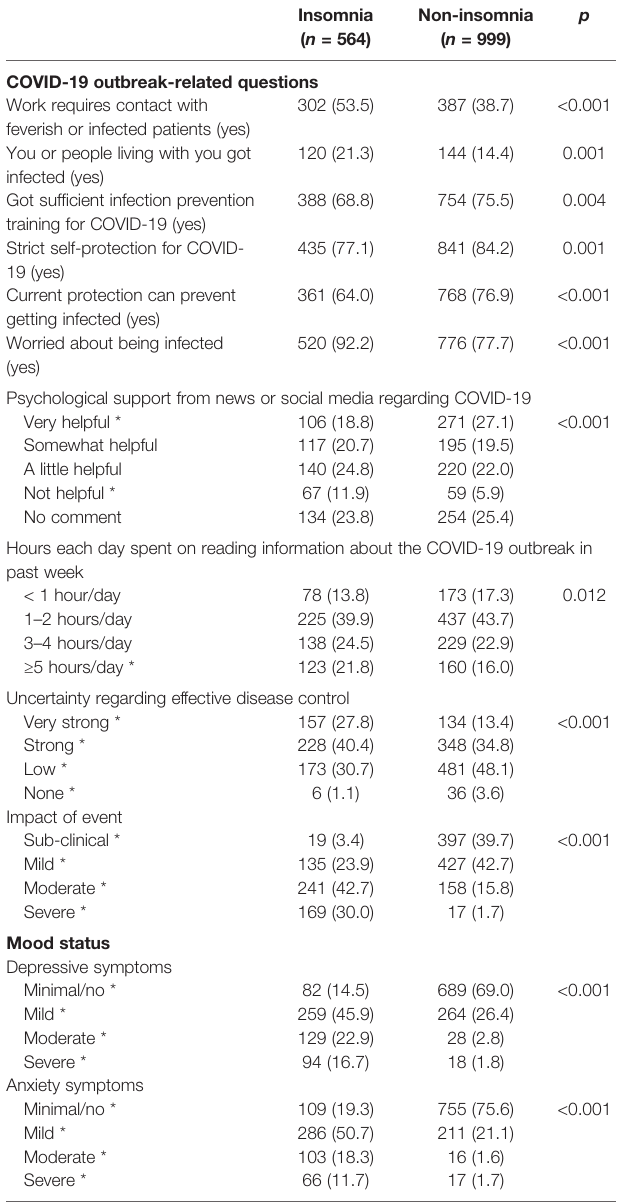
TABLE 1B | Comparisons between insomnia and non-insomnia individuals used chi-square tests on COVID-19 outbreak-related questions, and mood status.